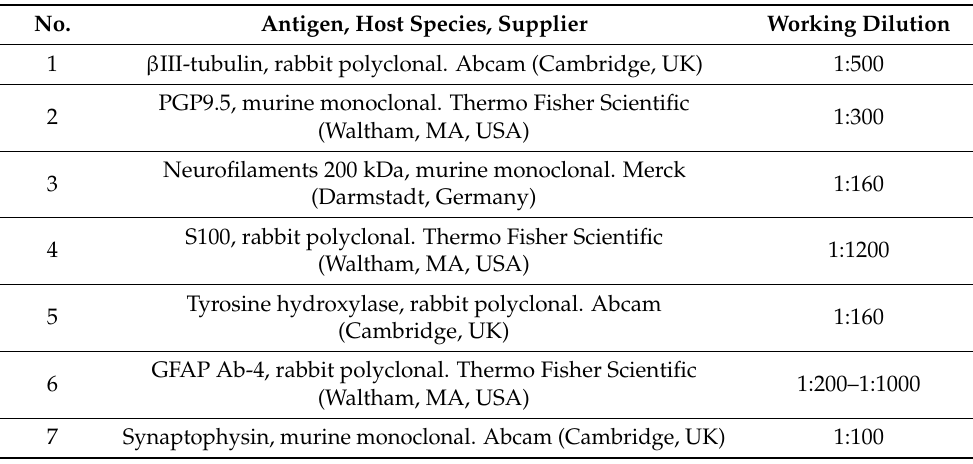
Table 5. Primary antibody